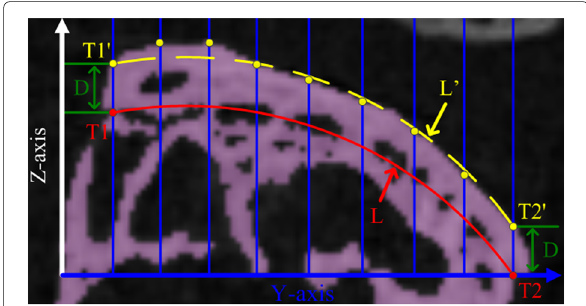
Fig. 8 Processes of the fitting based 2D shape priori extraction scheme. T 1 and T 2 are the terminal points of gap line L , T (cid:5) 1 and T (cid:5) 2 are the offset points from T 1 and T 2 by distance D , L (cid:5) is a spine approximates external edge of endplate generated according to the yellow control